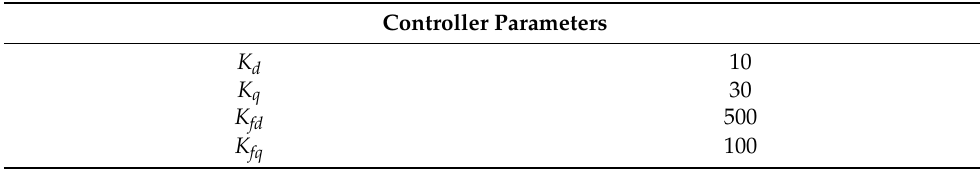
Table A2. Controller